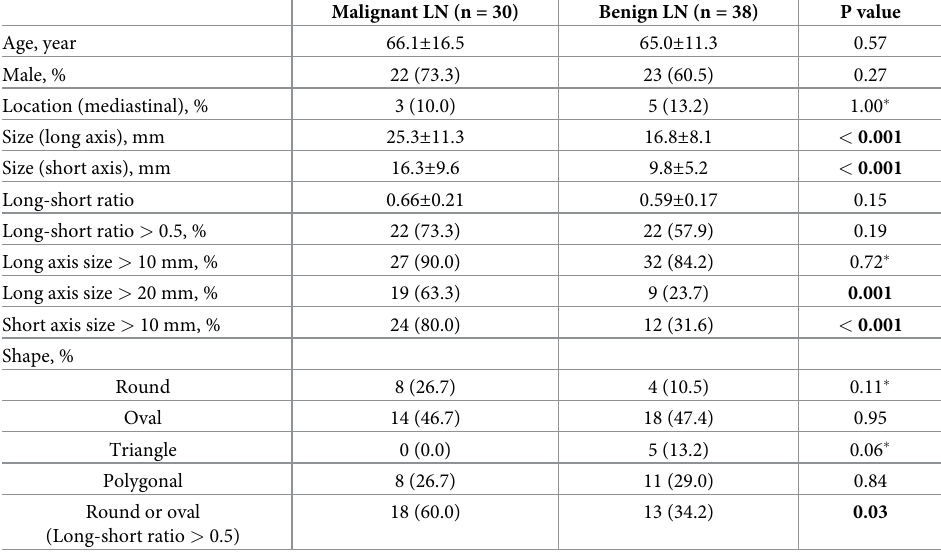
Table 1. Comparison of EUS features between benign and malignant lymphadenopathy.